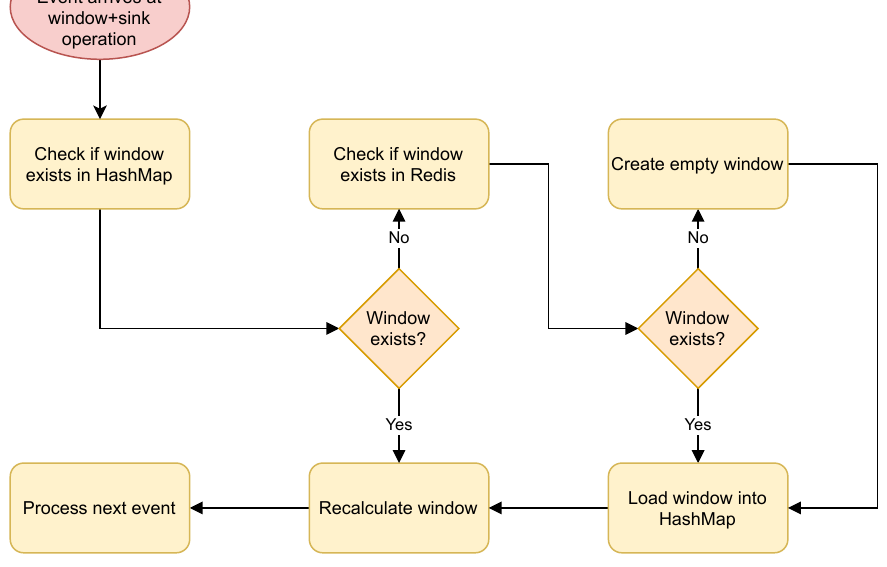
Figure 4. Spark CP windowing